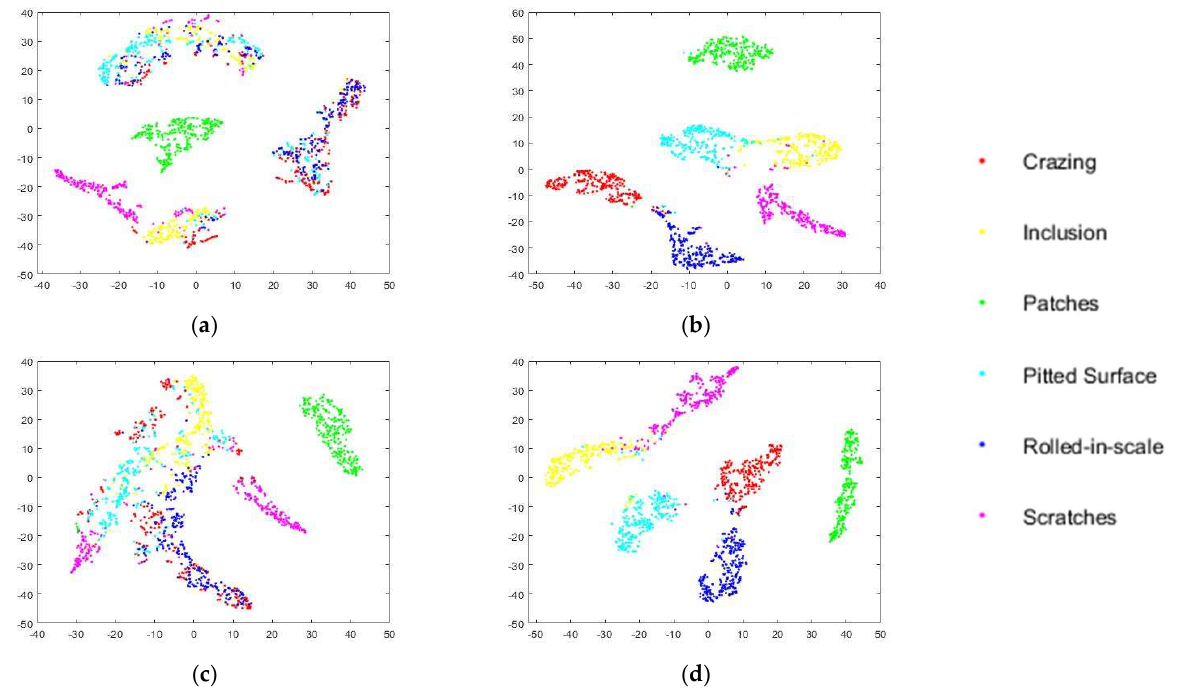
Figure 8. Feature visualization via t-SNE on salt and pepper noise (Density 0.3). The feature vectors are extracted from the activations of the fully connected layer. ( a ) The original level 0 model. ( b ) The retrained level 0 model. ( c ) The original level 1 model, ( d ) The retrained level 1 model.